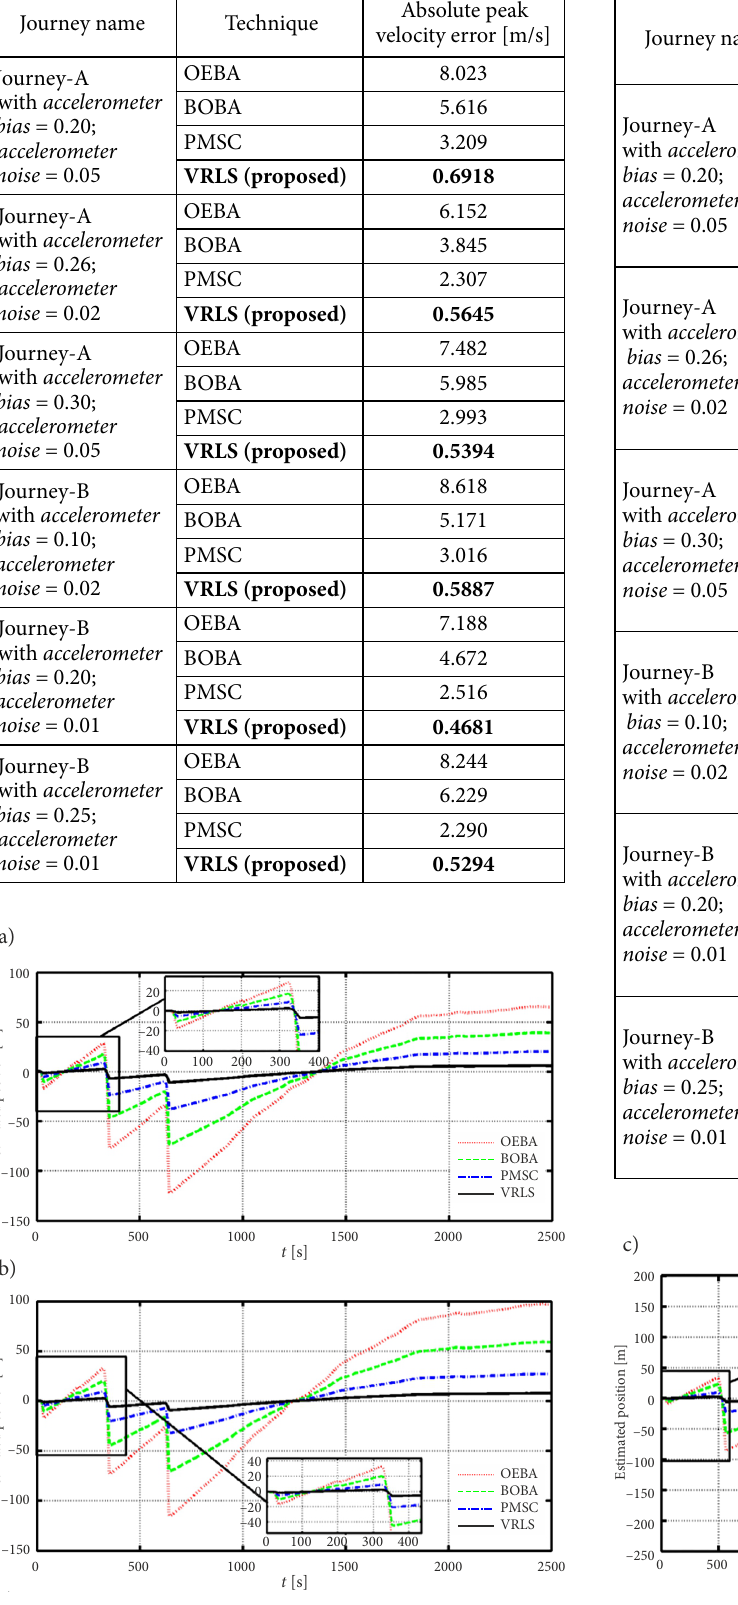
Figure 7. Estimations of position error for journeys with Profiles: a – Journey-A with Profile-1; b – Journey-A with Profile-2; c – Journey-B with